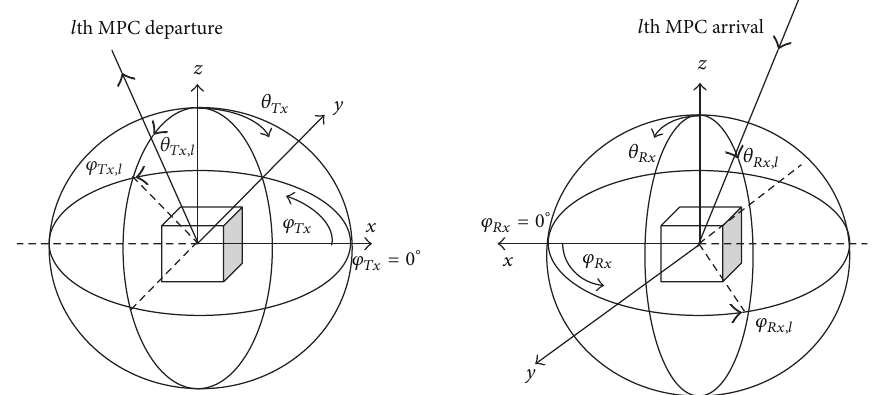
Figure 3: Transmitter and receiver cube array orientation and the definition of elevation and azimuth.